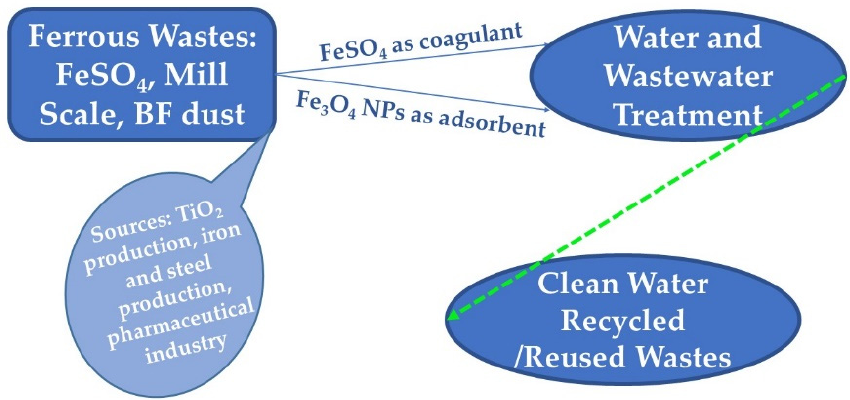
Figure 5. Ferrous wastes and their product applications for water and wastewater treatment.